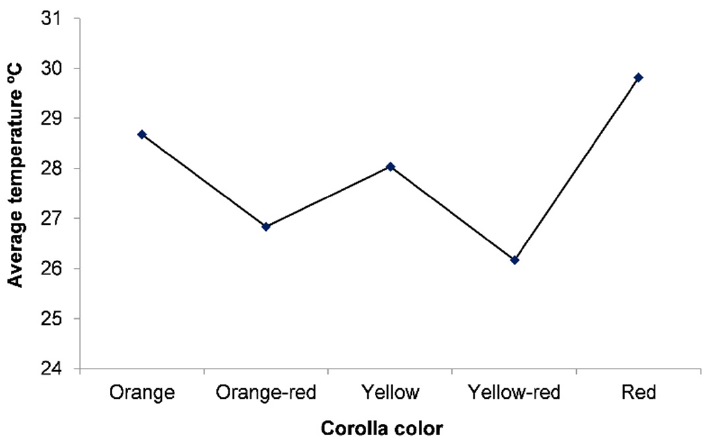
Figure 5. Corolla temperature averages of different Tropaeolum majus flower colors. The fluorescence test of T. majus flowers showed three intensity bands of different wavelengths (Figure 6), namely: first band (between 450 and 500 nm; Figure 6Aa, 6Ba, with a peak centered around 480 nm due to the presence of fluorophores (e.g., hy- droxycinnamic acid) [50] and flavonols (e.g., myricetin, quercetin, and kaempferol) [51]; second band (between 500 and 635 nm; Figure 6Ab, 6Bb), with two peaks, one at about 528 nm and another at about 564 nm, which may be related to the presence of β -carotene, with greater intensity compared to that of anthocyanin, respectively [52,53]; third band (Figure 6Ac, 6Bc), with two peaks, one at 670 and another at 722 nm, attributed to chloro- phyll a and b fluorescence, respectively [54]. Thus, we noted that red corolla flowers have a peak at 480 nm, which is smaller than those of orange and yellow corolla flowers (Figure 6Aa), and a larger peak at 670 nm, which is attributed to chlorophyll a and b fluorescence (Figure 6Ac).